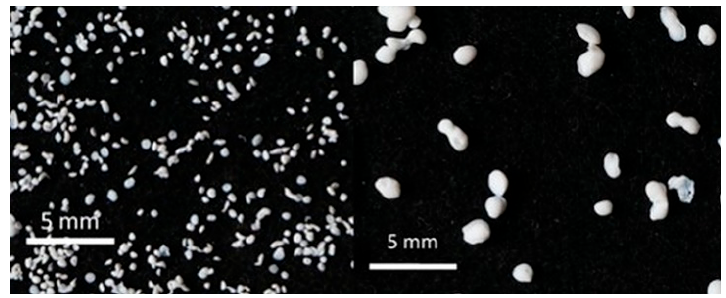
Figure 7. Chitosan aerogel particles (3 wt. %) via the jet cutting method: ( left ) a cylinder ratio of 5.3 and a nozzle diameter of 300 µm; ( right ) a cylinder ratio of 5.3 and nozzle diameter 700 µm.